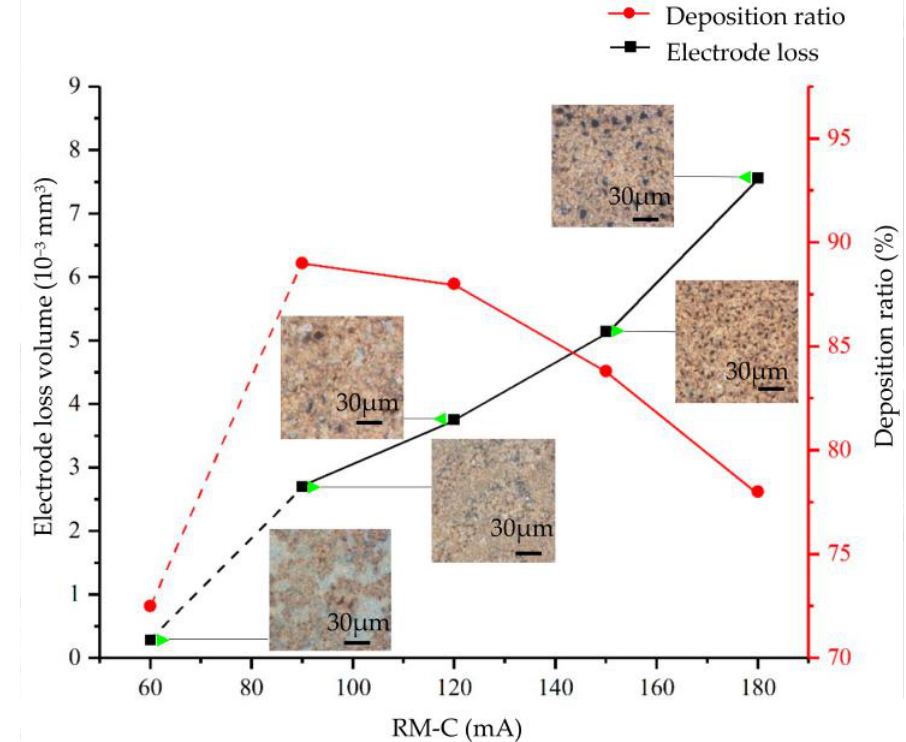
Figure 12. The e ff ect of RM-C on electrode loss volume and deposition ratio.